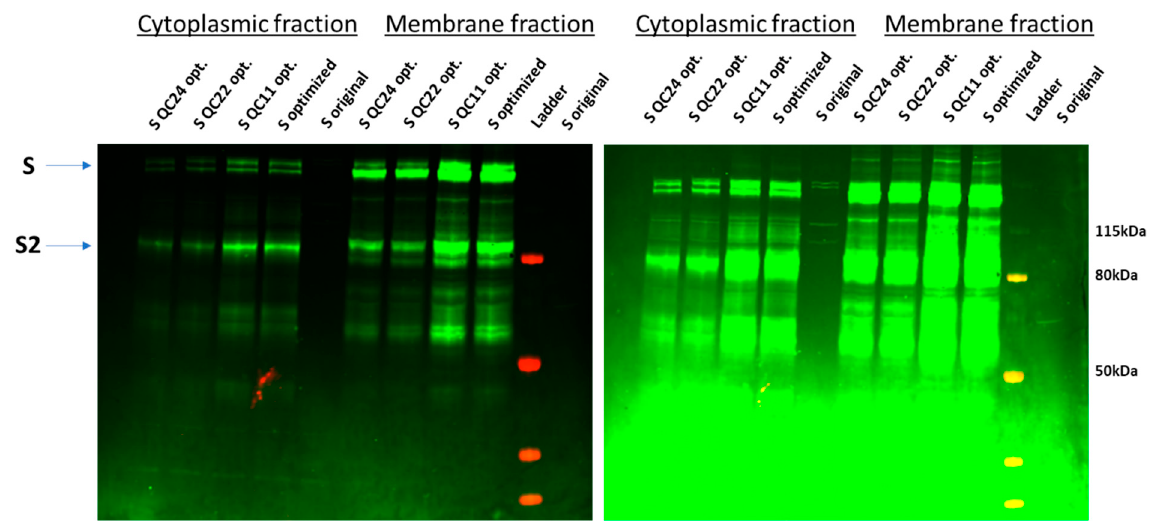
Figure 2. Expression of original and codon-optimized S proteins in HEK293F cell lysates. The left panel was imaged at normal gain, while the right panel was imaged at higher gain to visualize original S protein expression (S original). Experiments were repeated several times.